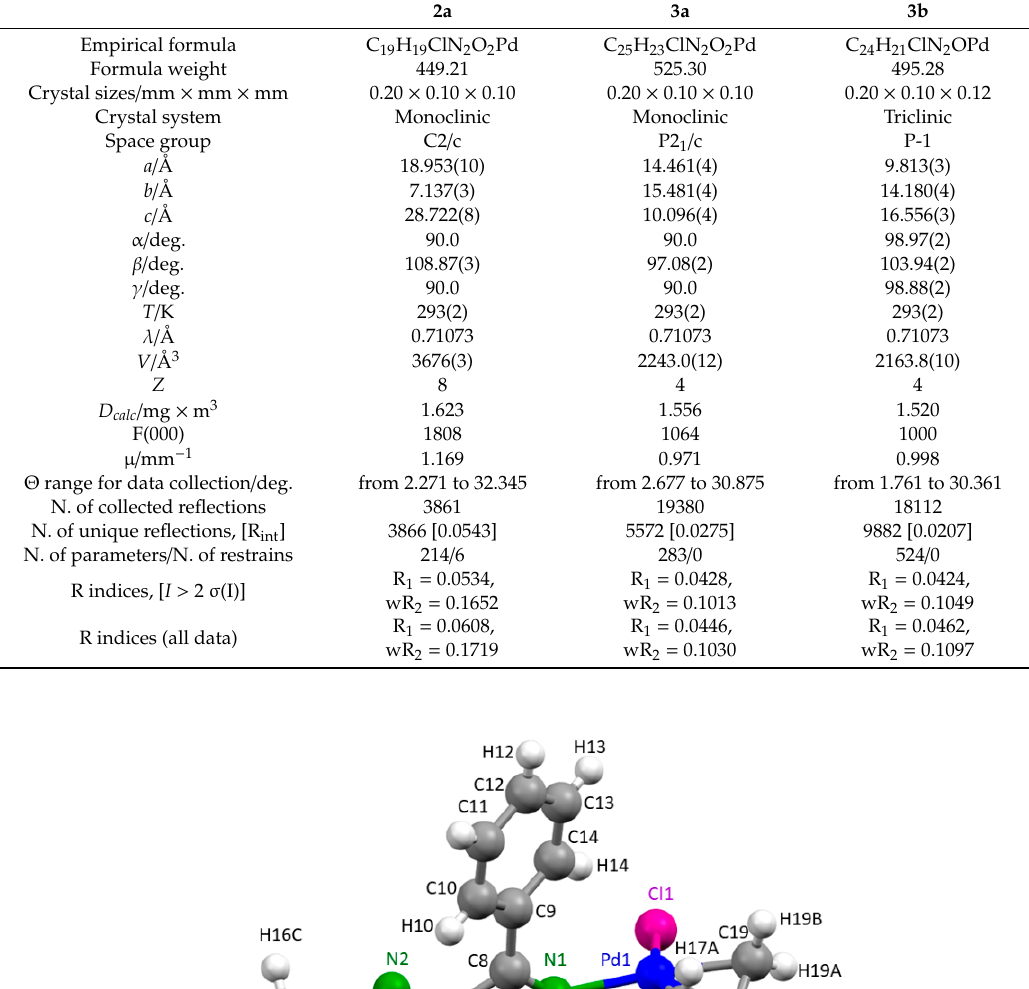
Crystal data and details of the refinement of the crystal structures of compounds